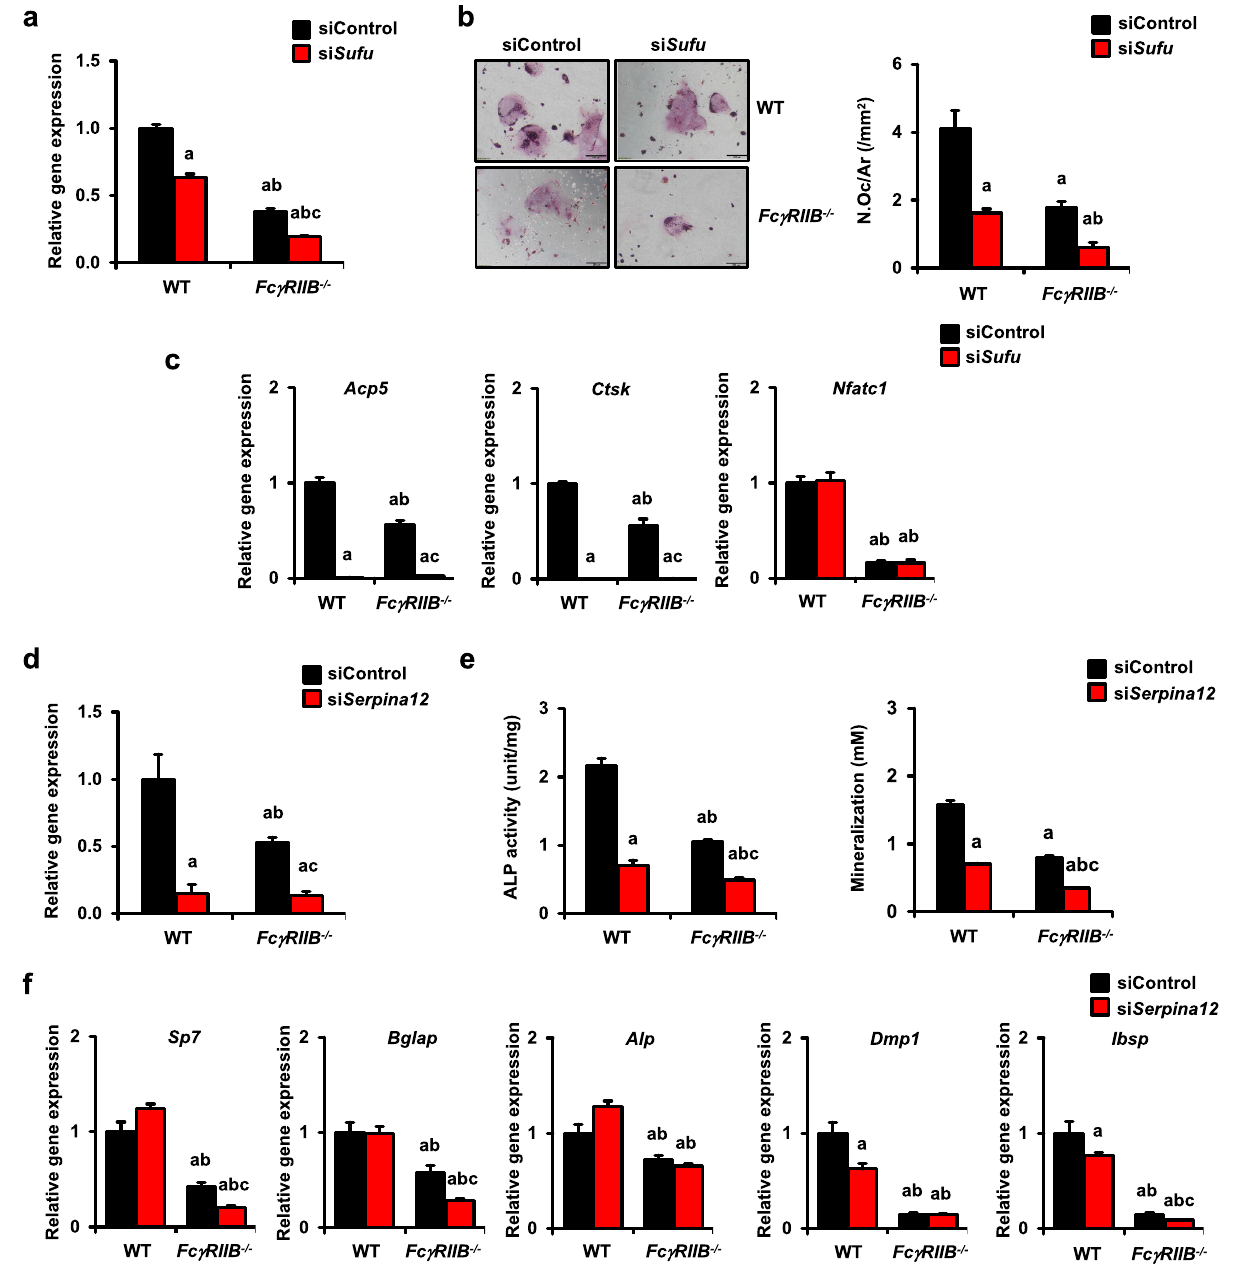
Figure 7. Sufu and Serpina12 deletion impaired osteoclastogenesis and osteogenesis in bone cells from WT and FcγRIIB -/- mice, respectively. ( a ) qPCR analysis of the efficiency of Sufu silencing in BMMs from mandibles of 6-month-old FcγRIIB -/- males and WT controls ( n = 3). ( b ) BMMs were transfected with si Sufu and siControl in the presence of M-CSF and RANKL. TRAP-positive osteoclasts with more than 5 nuclei were quantified using OsteoMeasure software. c The qPCR analysis of osteoclast gene expression after si Sufu transfection. ( d ) qPCR analysis of the efficiency of Serpina12 silencing in osteoblasts from FcγRIIB -/- mice and WT controls ( n = 4). ( e ) Osteoblasts were transfected with si Serpina12 and siControl in differentiation media. ALP activity (left) and mineralization (right) were quantified. ( f ) The qPCR analysis of osteoblast gene expression after si Serpina12 transfection. Data are mean ± SEM. a p < 0.05 compared to WT cells transfected with siControl, b p < 0.05 compared to WT cells transfected with either si Suf u or si Serpina12 , and c p < 0.05 compared to FcγRIIB -/- cells transfected with siControl. ALP; alkaline phosphatase, N.Oc; osteoclast number and Ar; area. Scale bar: 200